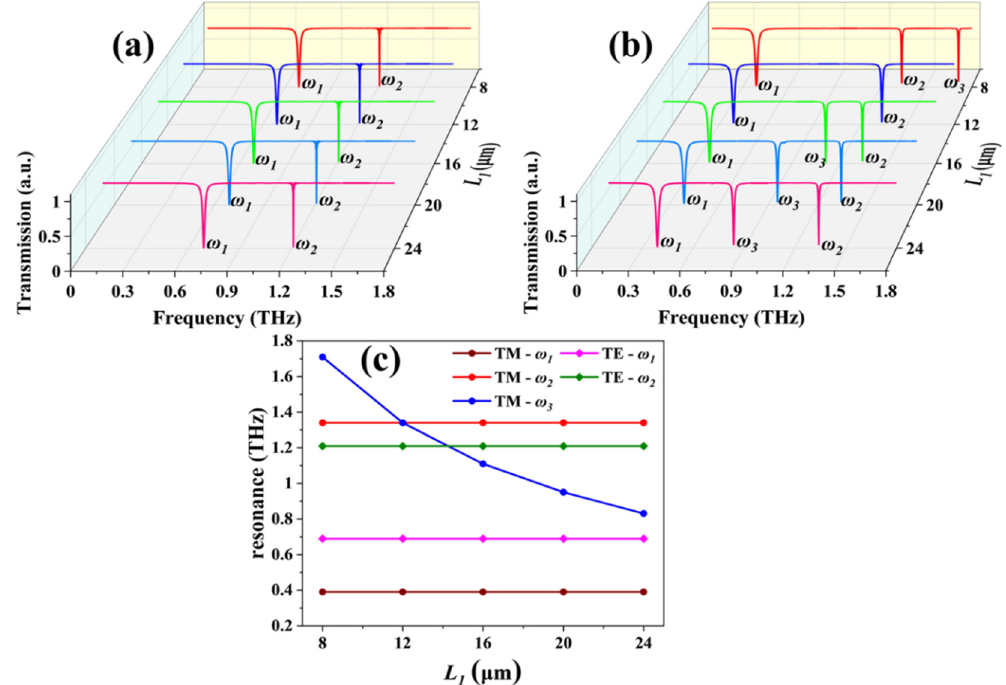
Figure 3. Transmission spectra of eSRR with different L 1 values in ( a ) TE and ( b ) TM modes. ( c ) The relationships between resonances and L 1 values are shown in ( a , b ).